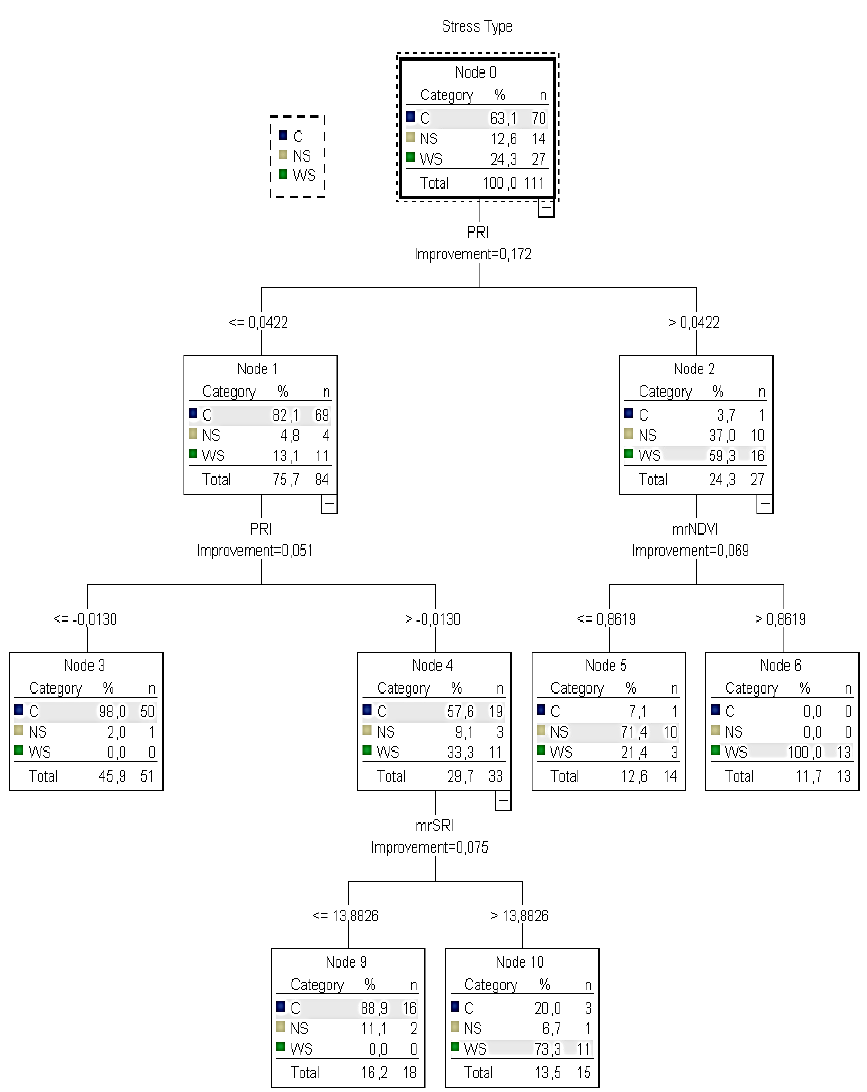
Figure 5. The CT4 classification tree of the training sample for calibration to identify healthy, water- and nitrogen-deficit stressed plants. C : indication of control plants; WS : indication of water deficit stress plants; NS : indication of nitrogen deficit stress plants.